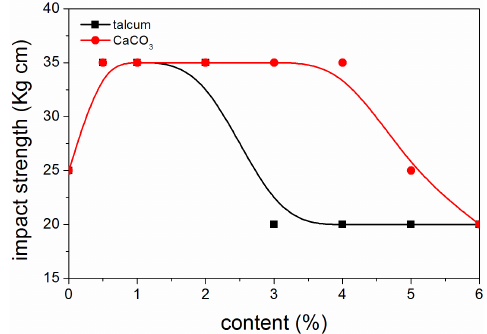
Figure 9. Effect of single filler on impact strength of coating (sample 5, 11–24 in Table 1).